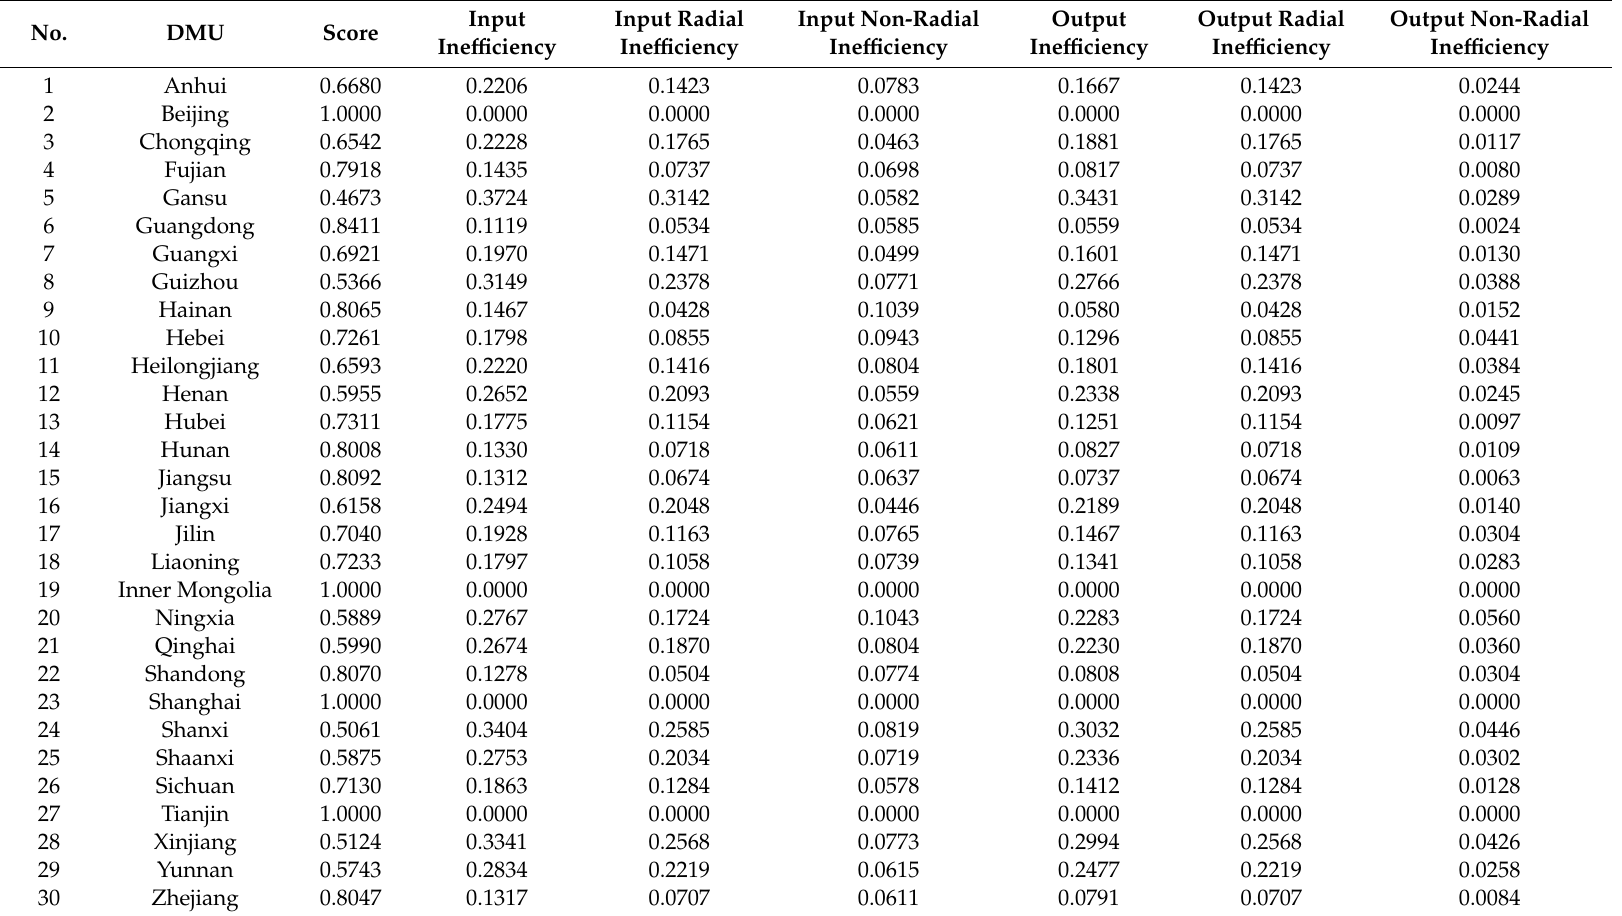
Table 5. 2014 input and output indicator radial and non-radial ine ffi ciency